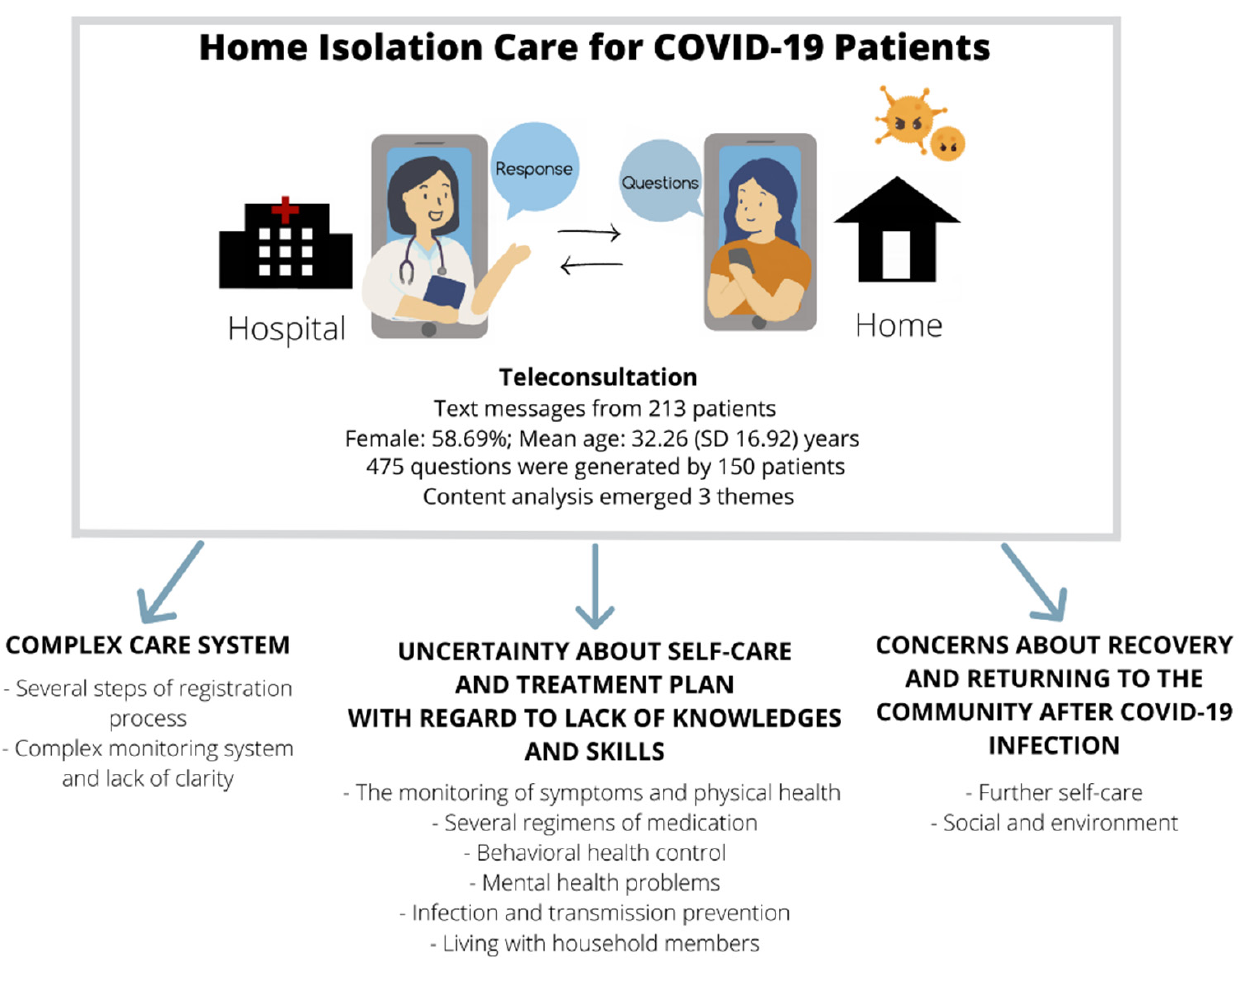
Figure 2. Summary of the results.